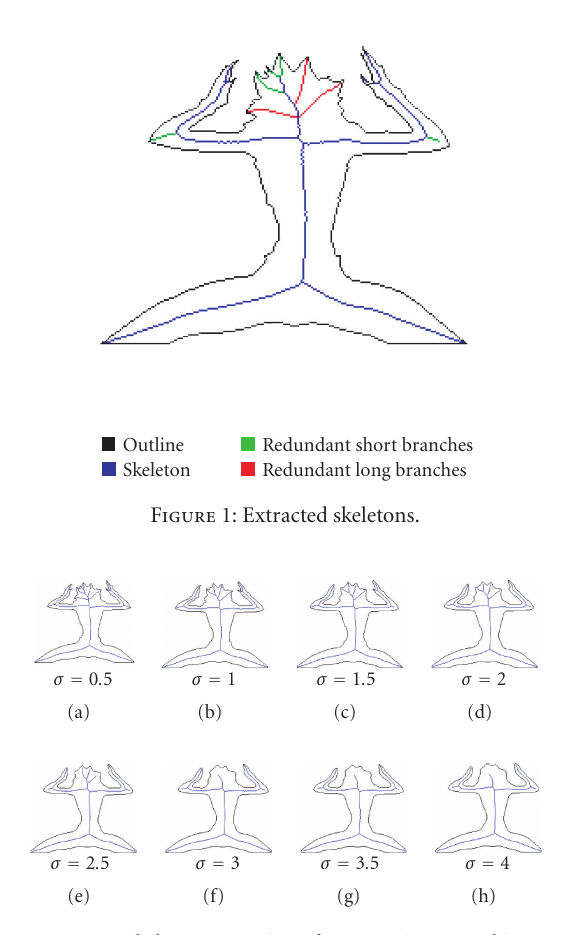
Figure 2: Skeleton extraction after Gaussian smoothing.